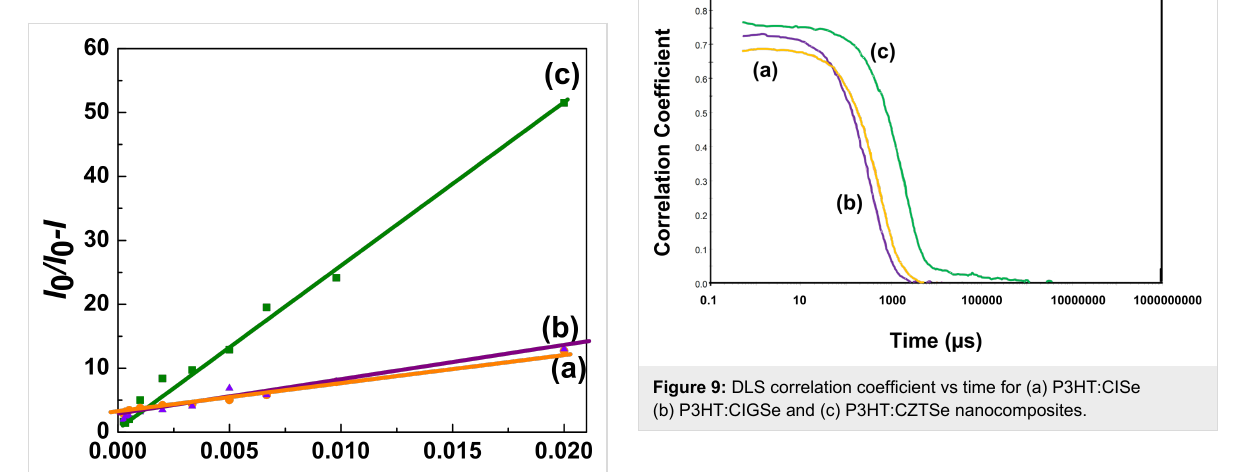
Raman spectroscopy can be used to probe the structure